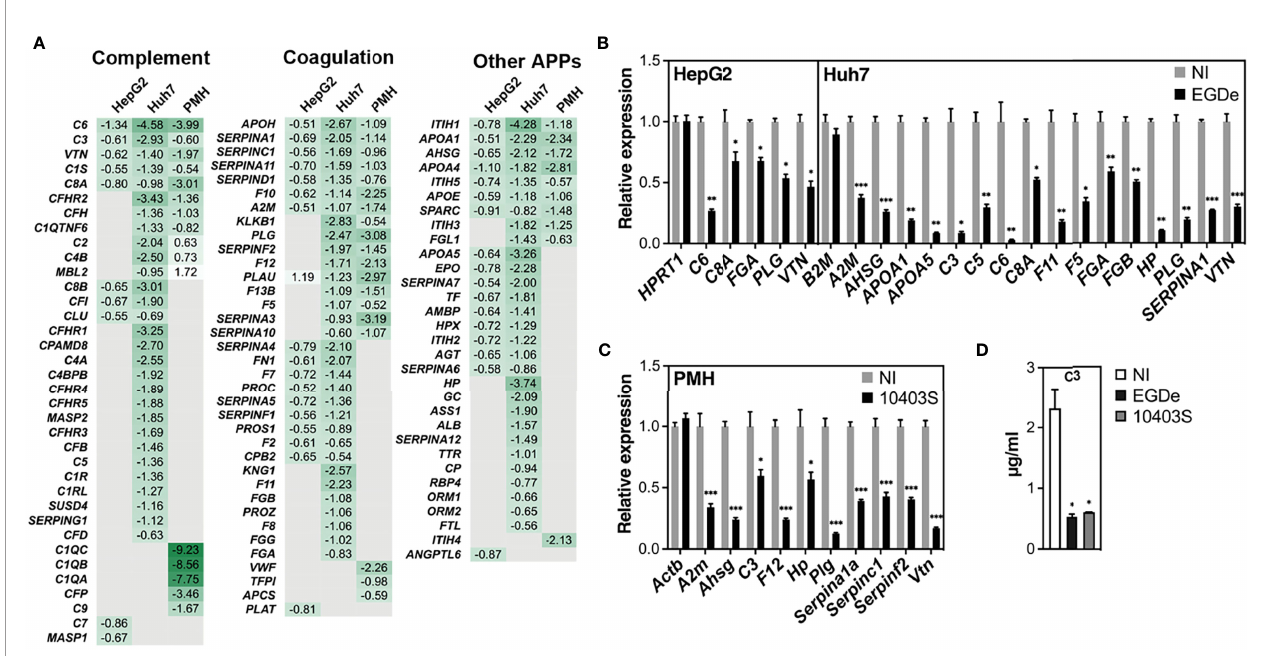
FIGURE 4 | Long-term Listeria infection downregulates expression of APP genes in hepatocytes. (A) Heatmap displaying log2 FC of APP genes signi fi cantly deregulated in infected cells compared to non-infected (NI) cells. APPs are classi fi ed according to their role in either the complement or coagulation systems or other functions. Gene symbols are indicated (corresponding gene names can be found in Supplementary Tables S3, S5, S7 ). Human C1S and SERPINA1 have several murine orthologues; FC for murine C1s1 and Serpina1a are shown. (B, C) RT-qPCR analysis of representative genes in (B) EGDe-infected HepG2 or Huh7 cells, and (C) 10403S-infected PMH, relative to NI cells. A non-differentially regulated control gene ( HPRT1 for Huh7, B2M for HepG2, and Actb for PMH) is included for each set. (D) C3 protein concentration in the conditioned media of NI or infected Huh7 cells at 72 h p.i. was measured by ELISA. All values represent mean ± SD